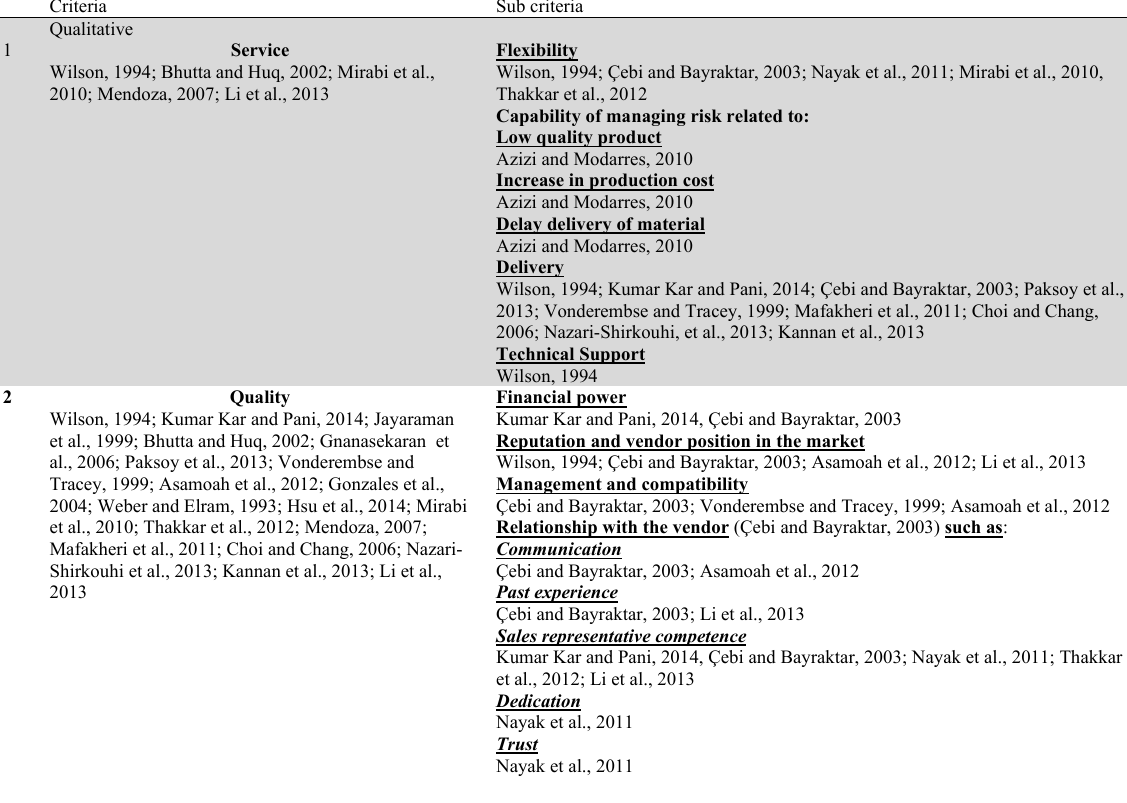
Criteria and sub criteria used in the previous researches on supplier selection